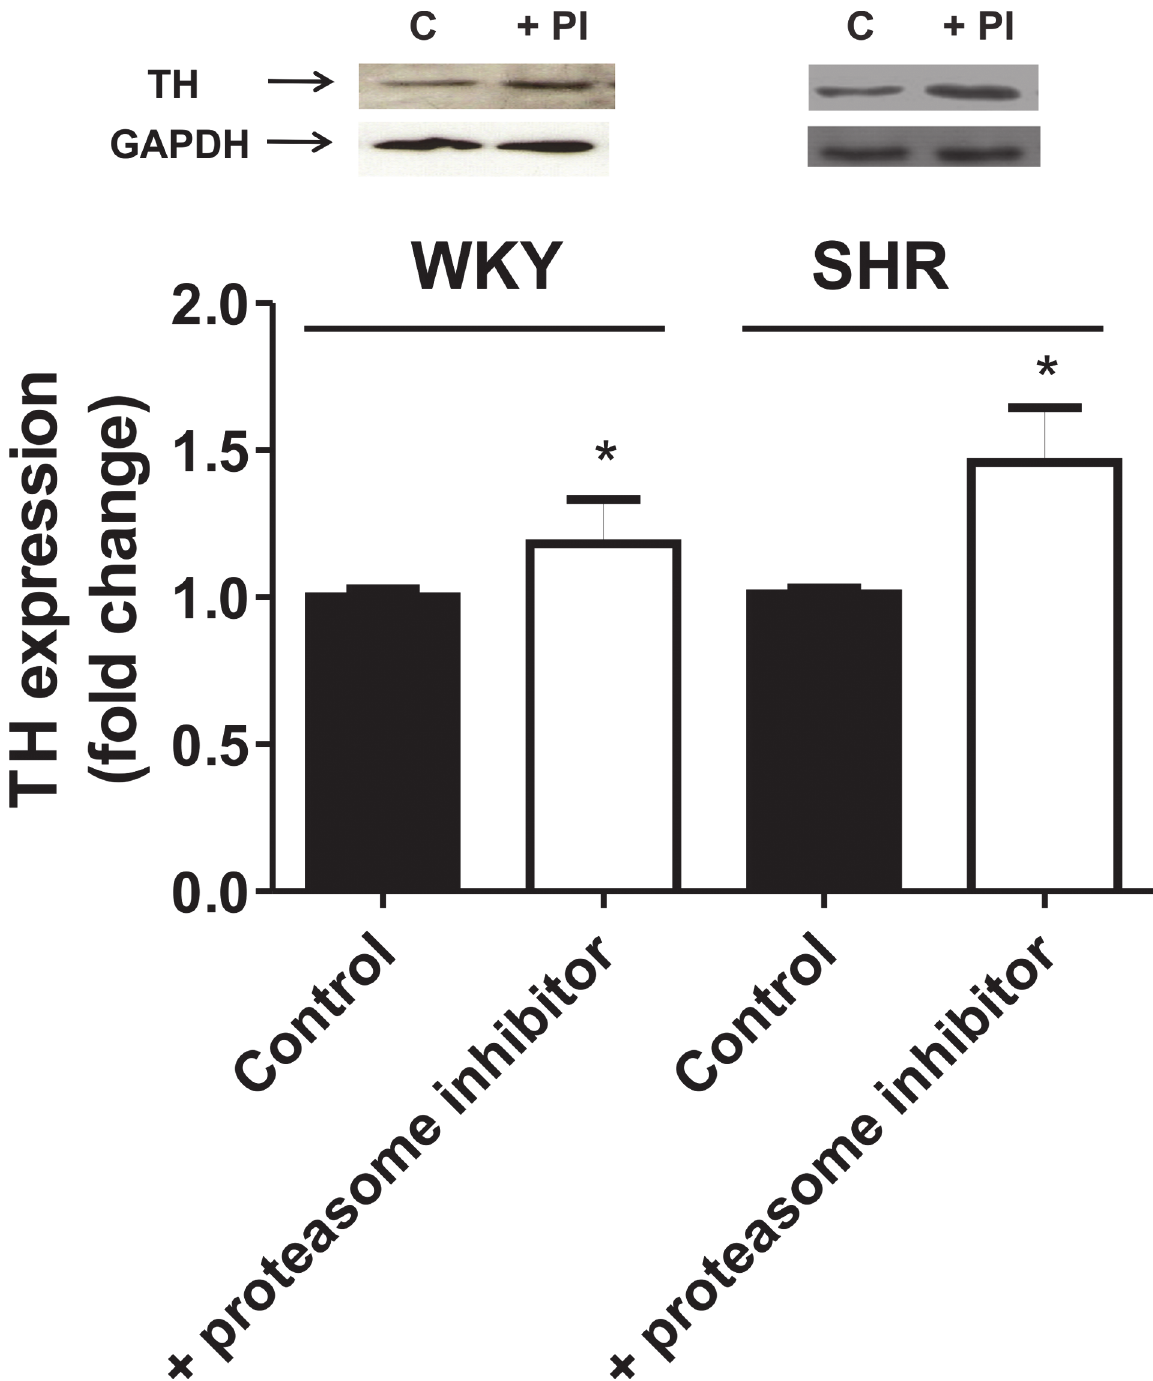
Fig 6. TH protein level in neuronal cultures from hypothalami and brainstem of WKY or SHR incubated in the absence (control) or presence of the proteasome inhibitor Lactacystin (5 μ mol/L) (PI) during 30 min. TH protein level was assessed by Western-blot as described under Methods. Blots were stripped and reprobed for GAPDH to assess protein loading. Signals from TH protein level were normalized to GAPDH levels. Each bar represents the mean fcfc ± SEM (n = 7). * P < 0.05 as compared to each corresponding